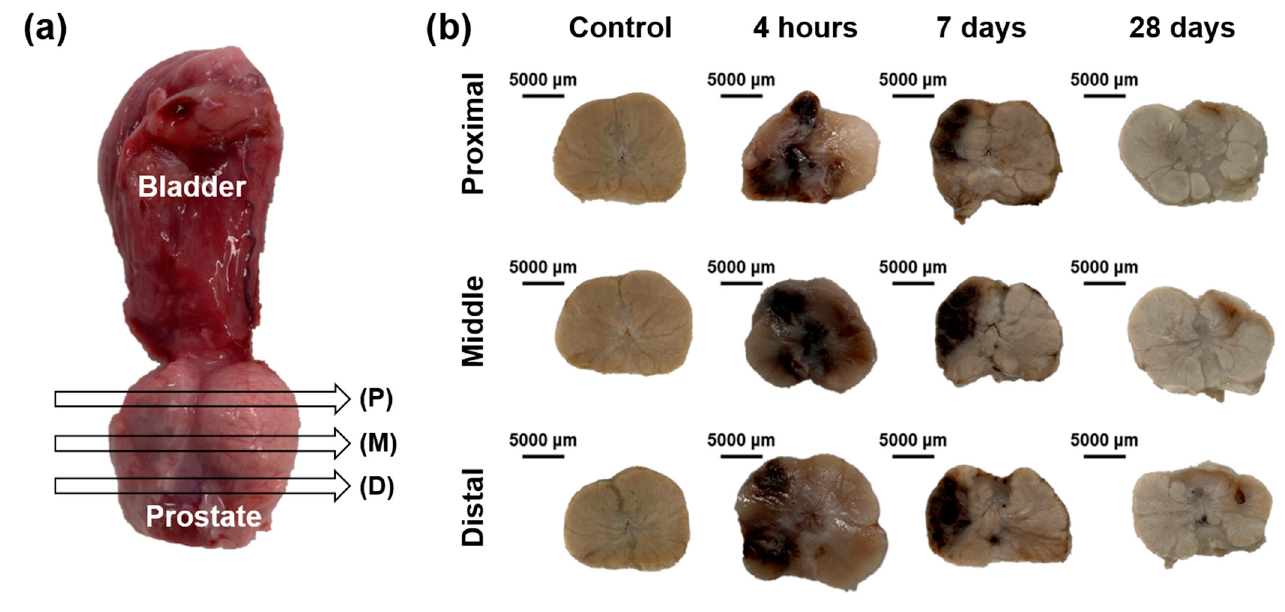
Figure 4. Tissue sampling and gross findings. ( a ) Prostate tissue samples showing the locations of (P) proximal, (M) middle, and (D) distal portions ablated by irreversible electroporation with high-frequency pulsed electric field. ( b ) Representative gross images of fixed prostate tissues.